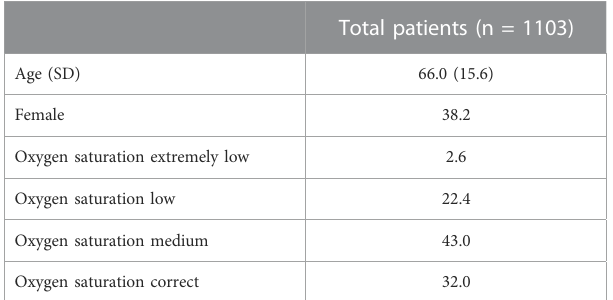
TABLE 1 Description of the characteristics (%) for COVID-19 patients included in the study.